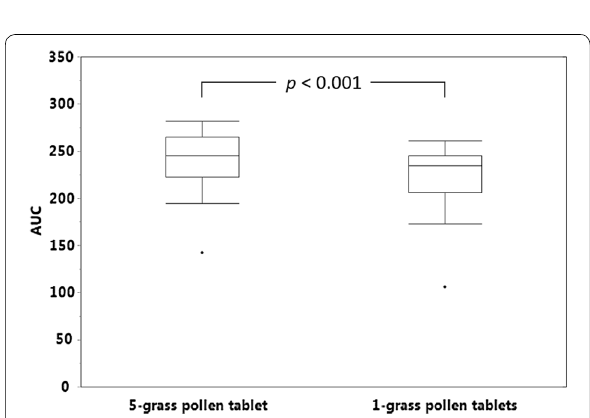
Fig. 3 AUCs obtained with one 5-grass pollen tablet and three 1-grass pollen tablets. AUCs were obtained in ELISA-inhibition experiments using microtiter plates coated with a 12-grass pollen extract and detection of serum IgE from Swedish patients ( n The p -value was obtained with the two-sided Wilcoxon signed rank